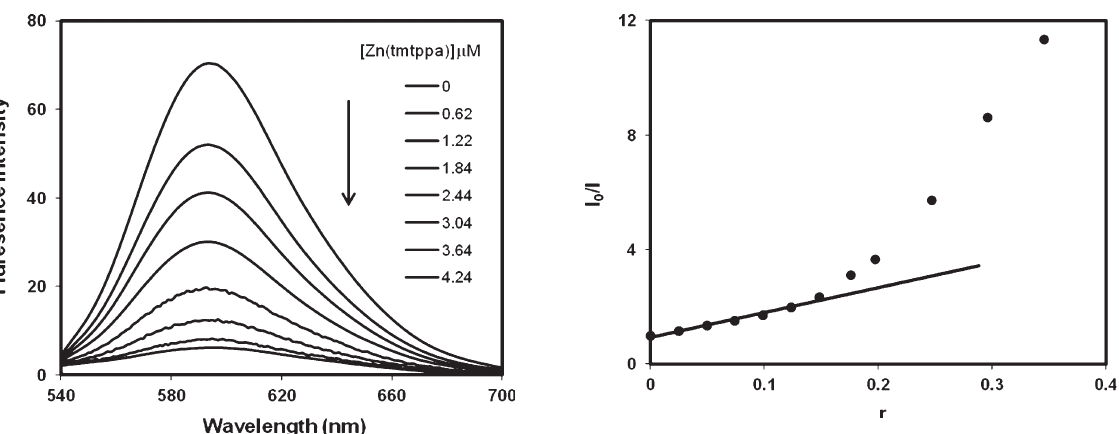
Fig. 6. Emission spectra of EB (5.00 (cid:1) M) bound to DNA (12.00 (cid:1) M) in the absence and the presence of different Zn(tmtppa) concentration in 5.5mM phosphate buffer, pH 7.2, λ ex =510nm